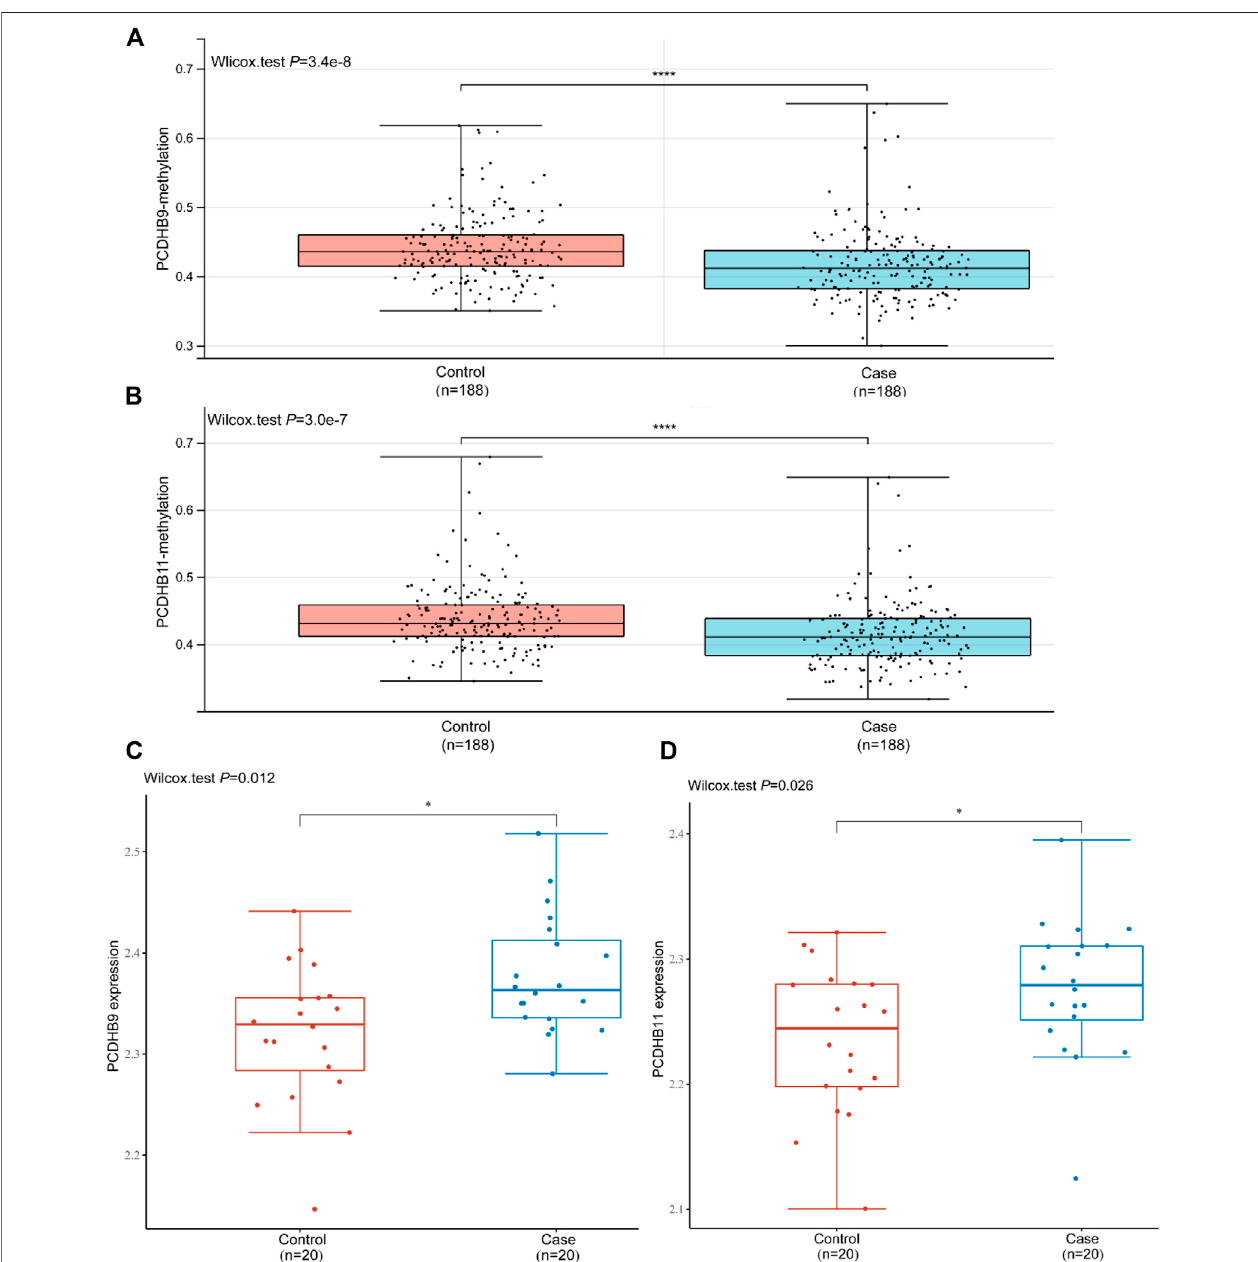
FIGURE 5 | Validation of the mRNA expression of PCDHB9 and PCDHB11 in GSE22255. (A) : Methylation level of the PCDHB9 gene in the control and case (IS) groups; (B) : Methylation level ofthe PCDHB11 gene inthecontrol and case(IS) groups; (C) : mRNAexpression ofthe PCDHB9 genein thecontrol and case(IS) groups; (D) : mRNA expression of the PCDHB11 gene in the control and case (IS) groups. *Statistically signi fi cant difference ( p < 0.05). ****Statistically signi fi cant difference ( p <